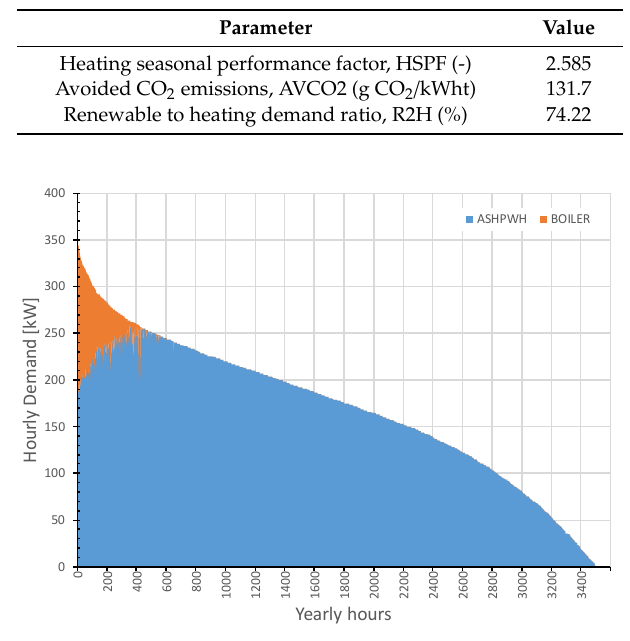
Table 8. Performance indexes in the baseline case.